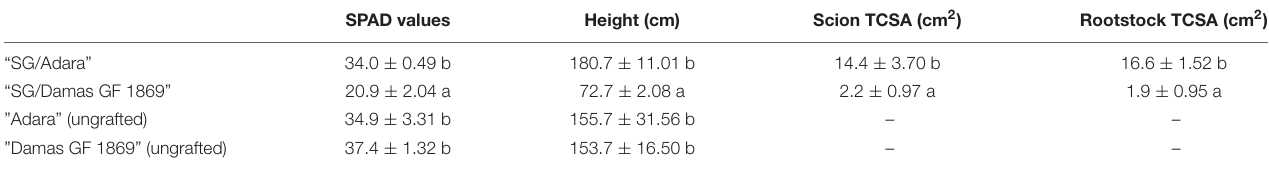
TABLE 1 | SPAD values and tree growth parameters determination of “Summergrand” nectarine cultivar grafted on two plum-based rootstocks (“Adara” and “Damas GF 1869”) 3 years after